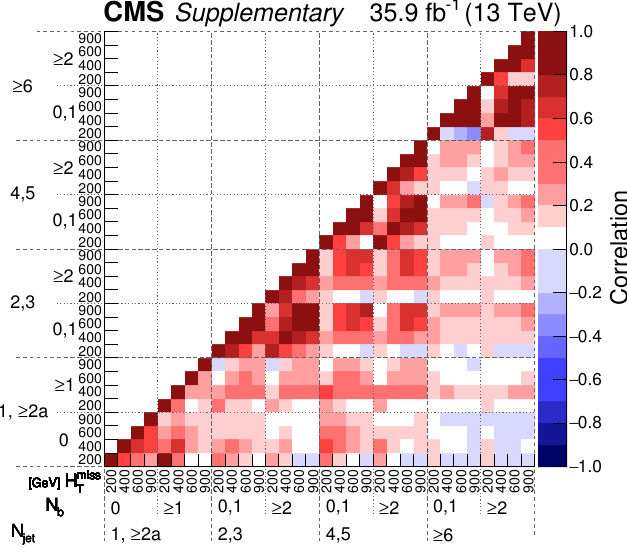
Figure 5 . Correlation matrix for the SM background estimates determined from the CR-only (cid:12)t using the simpli(cid:12)ed binning schema de(cid:12)ned in table 7.